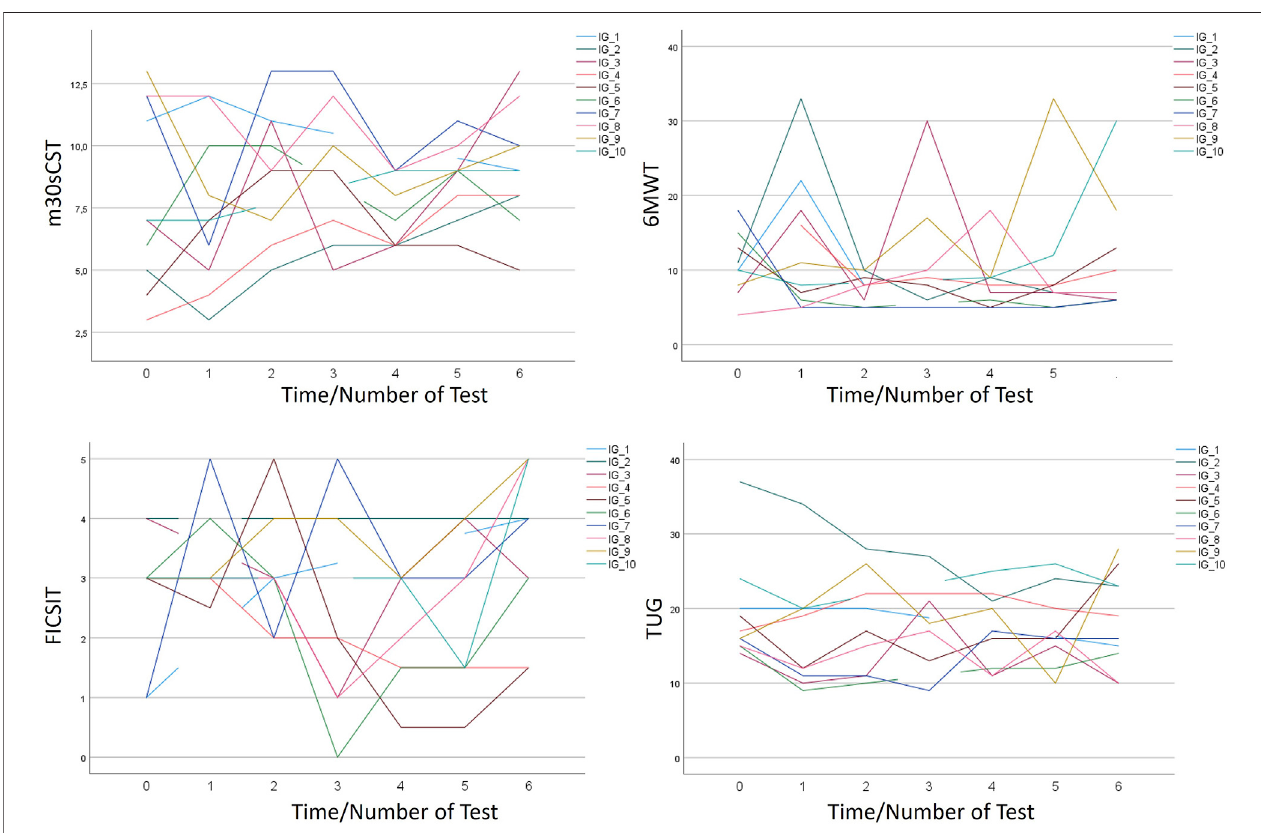
FIGURE 2 | Individual development of physical performance based on 6MWT, FICSIT-4, m30CST, and TUG tests.